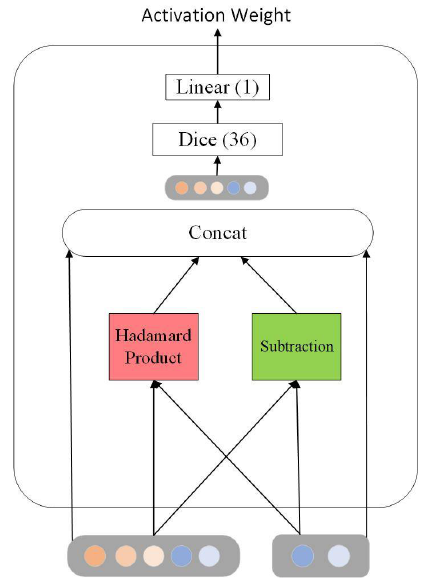
Figure 2. Local activation